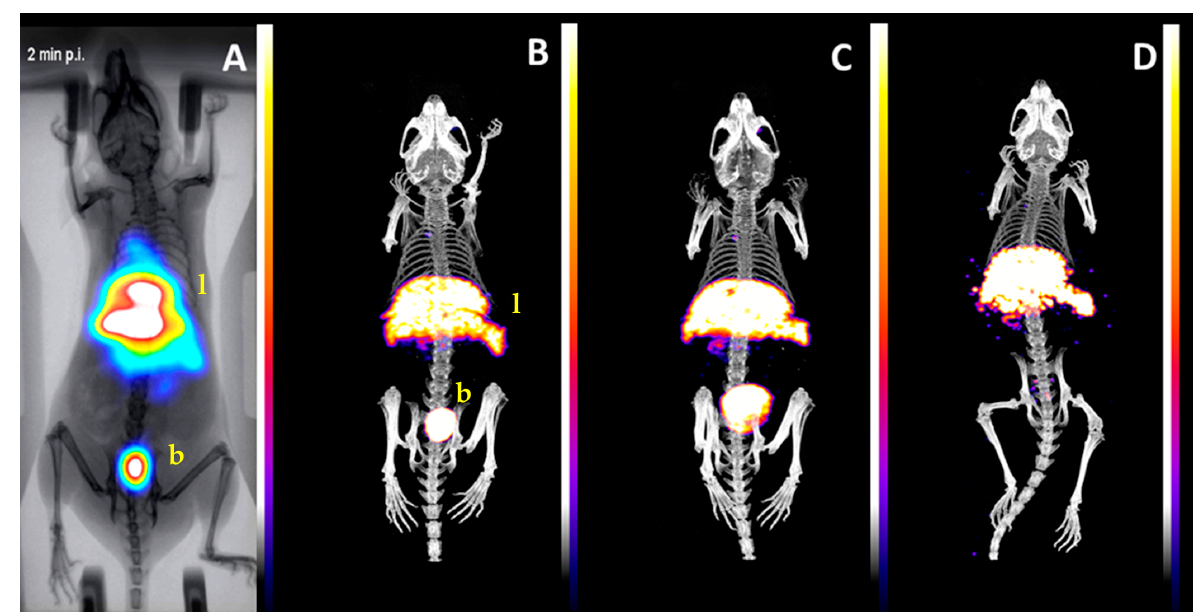
Figure 6. 2D and 3D imaging after intravenous injection of the 99m Tc-labeled mannosylated dextran mannose receptors targeting agent 99m Tc-D75CM in healthy Swiss Albino mouse. ( A ) Dynamic imaging for 30 min just after injection with γ -eye ΤΜ . ( B ) Tomographic imaging for 30 min at 1 h p.i., ( C ) tomographic imaging for 30 min at 3 h p.i., and ( D ) tomo- graphic imaging for 50 min at 24 h p.i. with x-CUBE TM /y-CUBE TM , respectively. The color bar indicates the accumulation level (i.e., white being the highest and purple the lowest). Bladder (b); Liver (l).